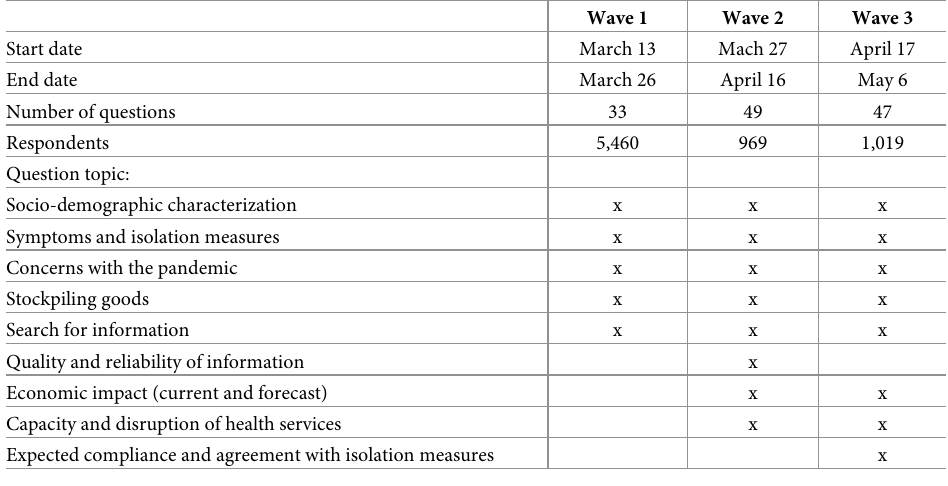
Table 1. Key information of survey